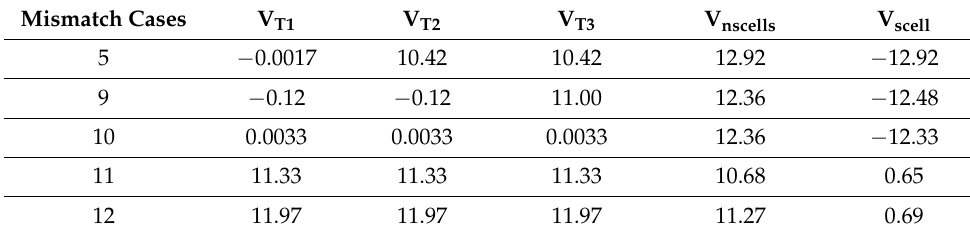
Table 4. Voltage across shaded PV sub-modules and PV cell(s) equipped with DC optimizers.